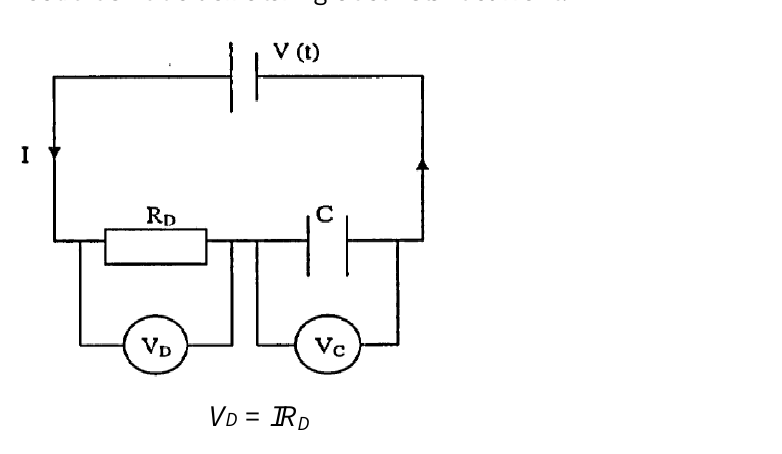
Figure 4. Electro osmotic dewatering at constant